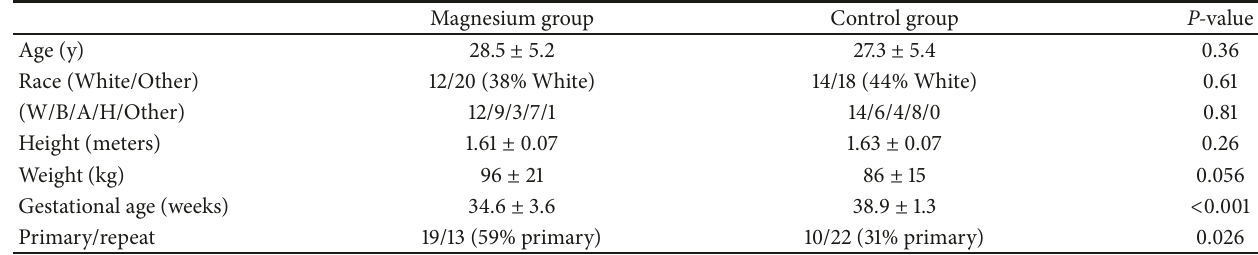
Table 1: Patient demographics and pregnancy characteristics in the magnesium and control groups. Data presented as the mean ± standard deviation and as percentage for counts.